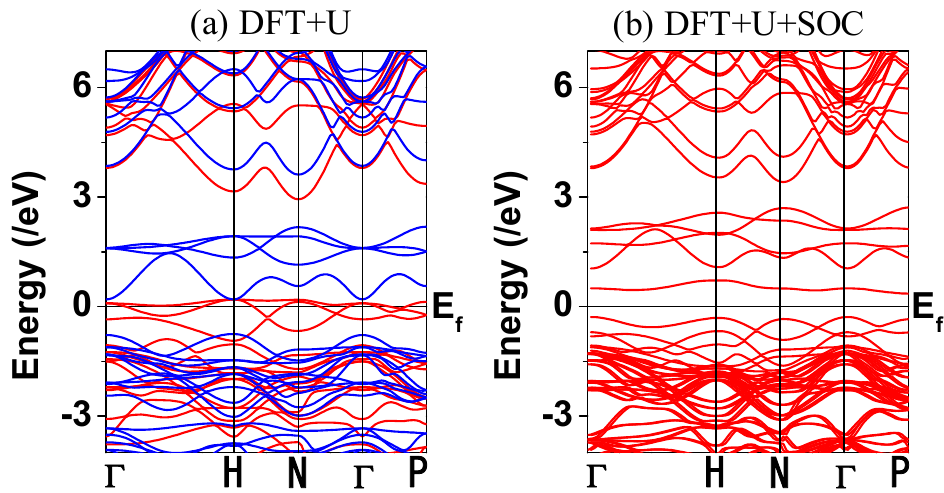
Figure 6. Band structures calculated for Ba 2 CuOsO 6 using different methods with U value set of U Cu = 4 eV, U Os = 5 eV. ( a ) DFT + SOC, ( b ) DFT + U + SOC. In ( a ), red and blue colors refer to the spin-up and spin-down bands,